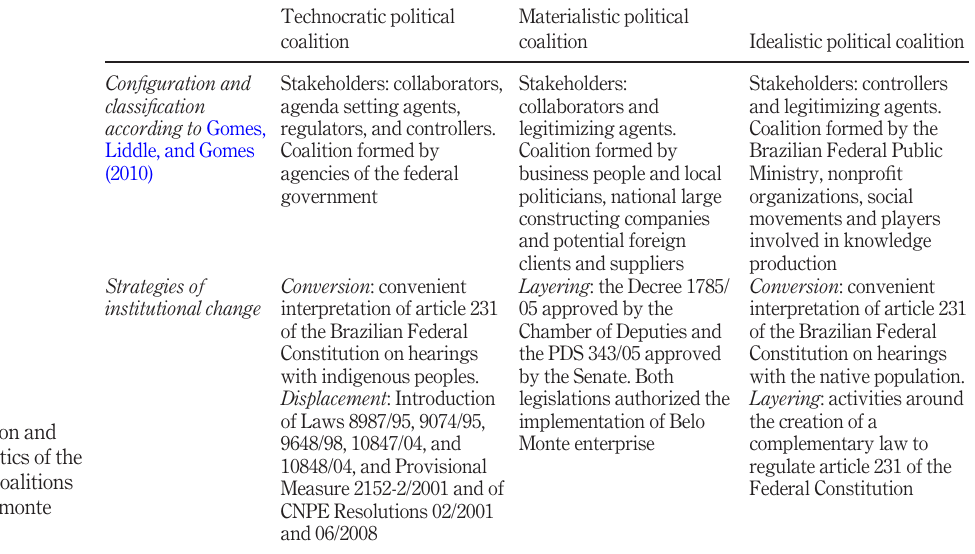
Table I. Identi fi cation and characteristics of the advocacy coalitions of the belo